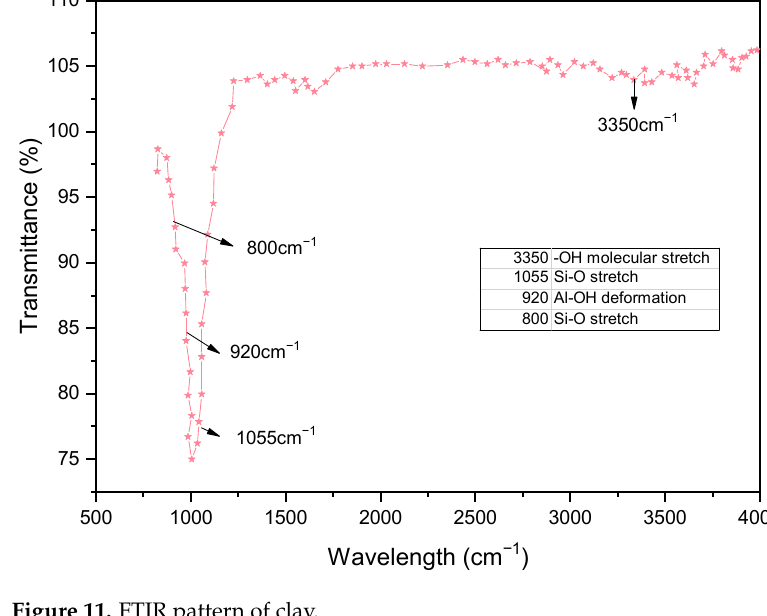
Figure 11. FTIR pattern of clay.